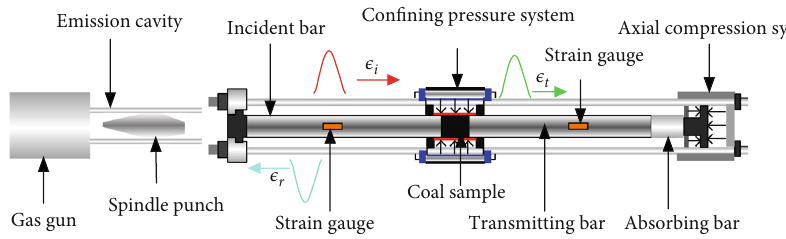
Figure 4: The Hopkinson pressure bar apparatus.